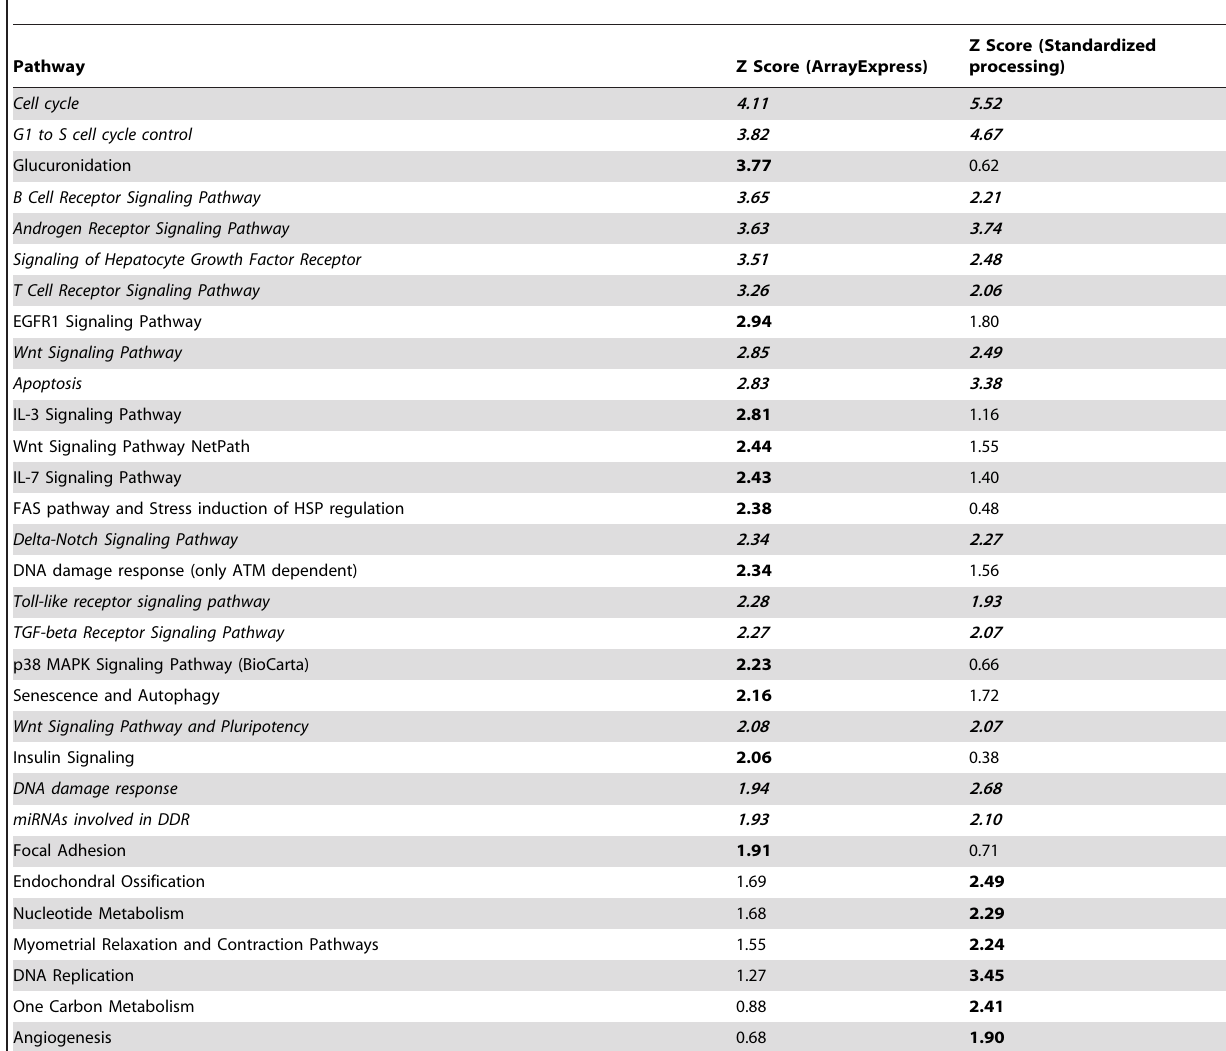
Table 3. PathVisio results of significant pathways found in the dataset by Varambally et al. comparing processed data provided by ArrayExpress with the reprocessed